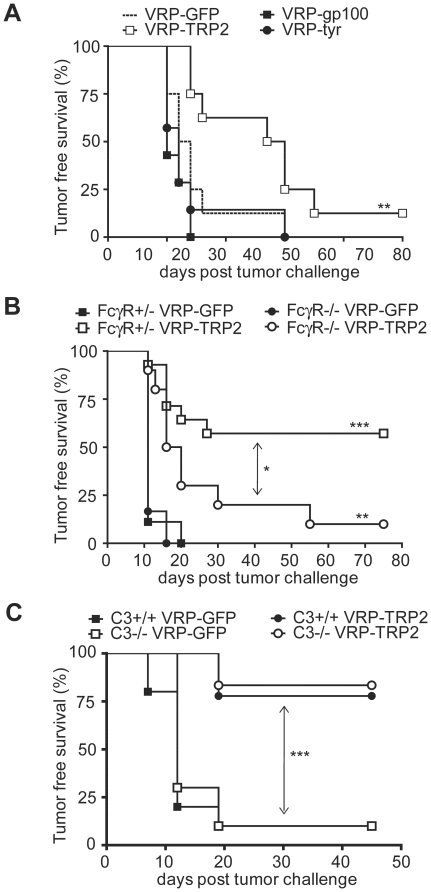
VRP-TRP2 humoral anti-tumor effect is mediated by Fc Receptors.Kaplan-Meier tumor-free survival curves of (A) 7–9 NAÏVE recipient mice per group, transferred with sera from donor mice vaccinated with the indicated VRP; (B) Eight to 14 FcγR −/− or +/− littermate control mice vaccinated with VRP-TRP2 or VRP-GFP; (C) Twelve C3 −/− or +/+ control mice vaccinated with VRP-TRP2 or VRP-GFP. *** P<0.0001, ** P<0.001, * P<0.01.